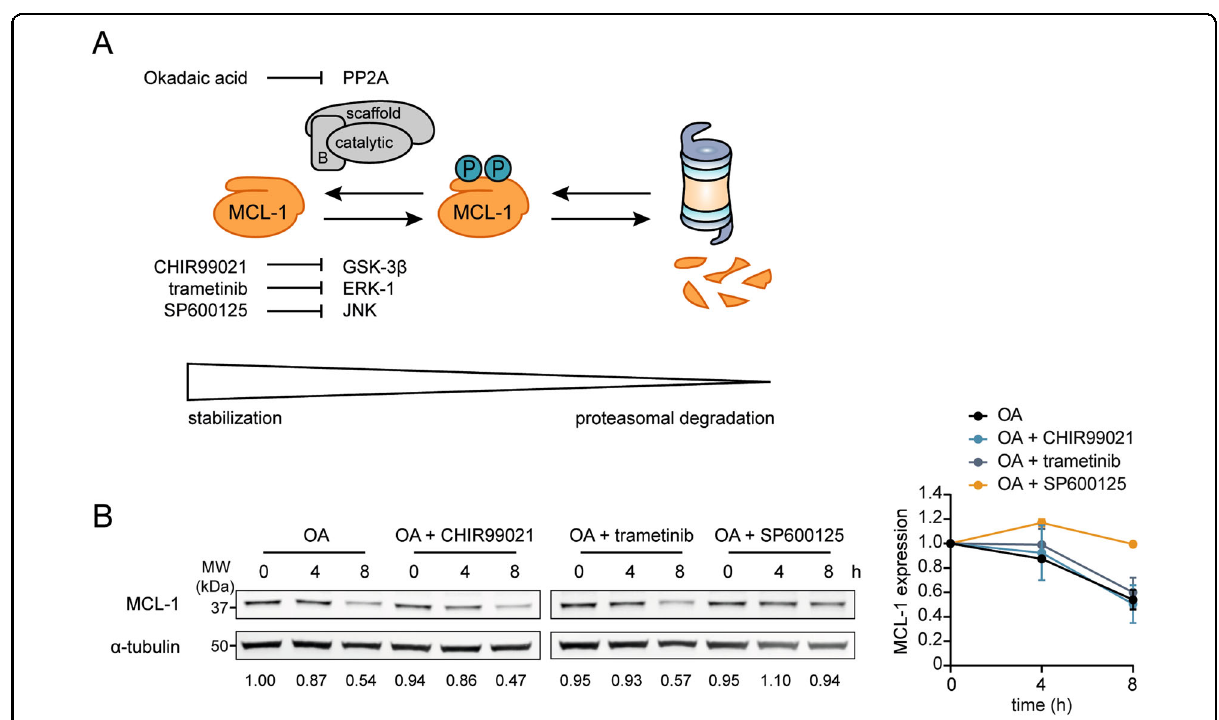
Fig. 6 PP2A reverses MCL-1 phosphorylation by JNK. A Model of MCL-1 phosphorylation leading to proteasomal degradation, which is counteracted in a subset of MM by PP2A phosphatase activity. Potential kinases phosphorylating and destabilizing MCL-1 are GSK-3 β , ERK-1, and JNK. The PP2A and kinase inhibitors used in this study are indicated. B MCL-1 expression in MM1.S after treatment for 0, 4, and 8 h with 100 nM OA, either alone or combined with 10 µM CHIR99021, 250 nM trametinib, or 20 µM SP600125. Data represent two independent experiments. Quanti fi ed MCL-1 levels (normalized to α -tubulin level and relative to untreated) are shown below the bands and are average of two experiments. The graph shows averages of two independent replicates